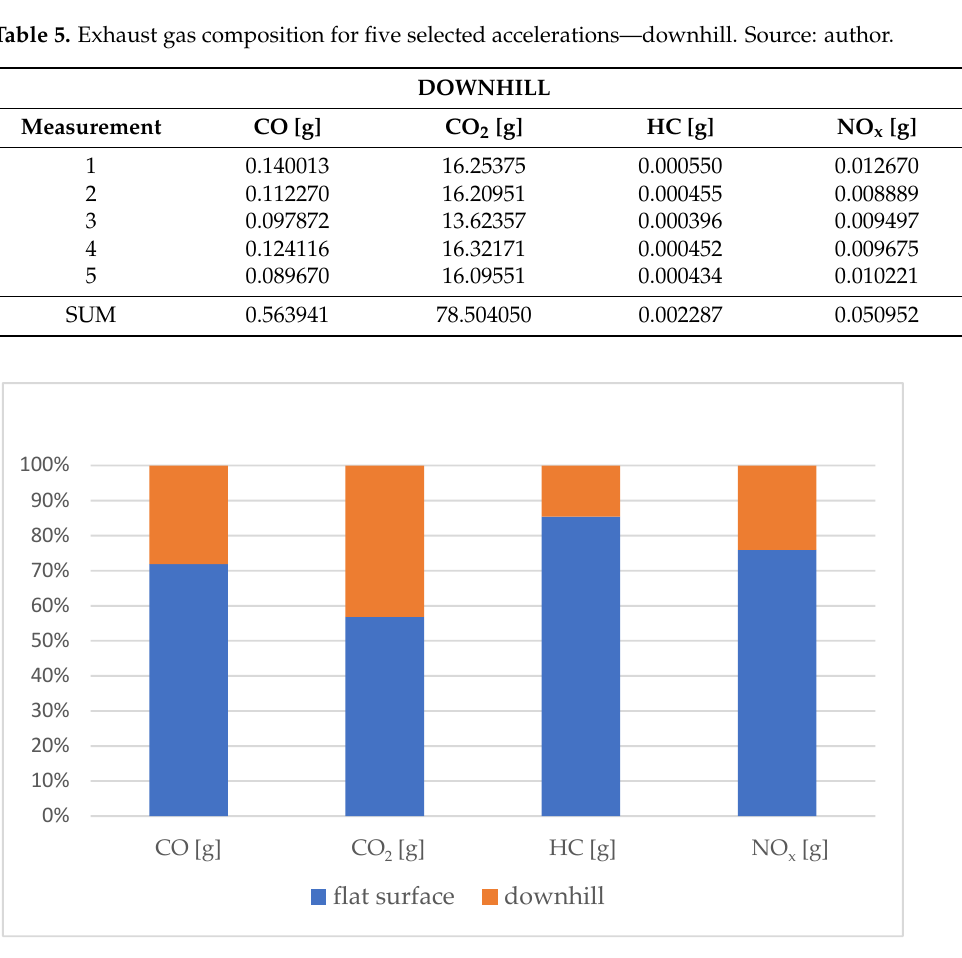
Figure 4. Composition of exhaust gas emissions according to Tables 3 and 4. Source: author.